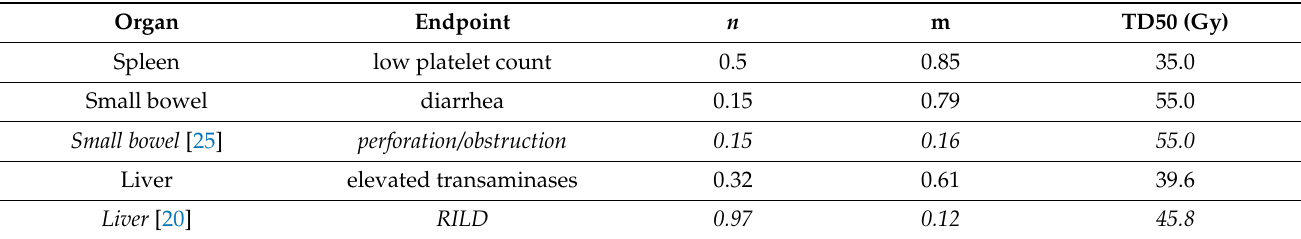
Table 3. Estimated Lyman–Kutcher–Burman (LKB) model parameters for low-grade toxicities and respective literature values for liver and bowel toxicities.